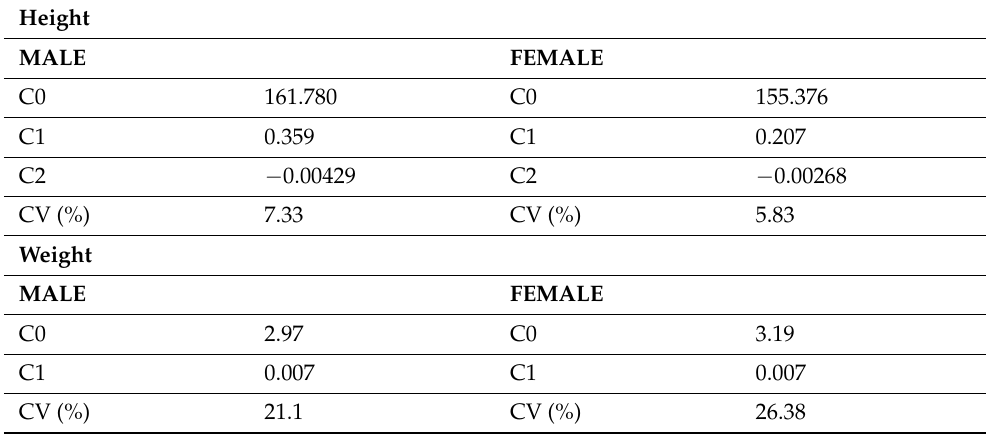
Table 2. Height–weight parameters for the Black South African population for both males and females.